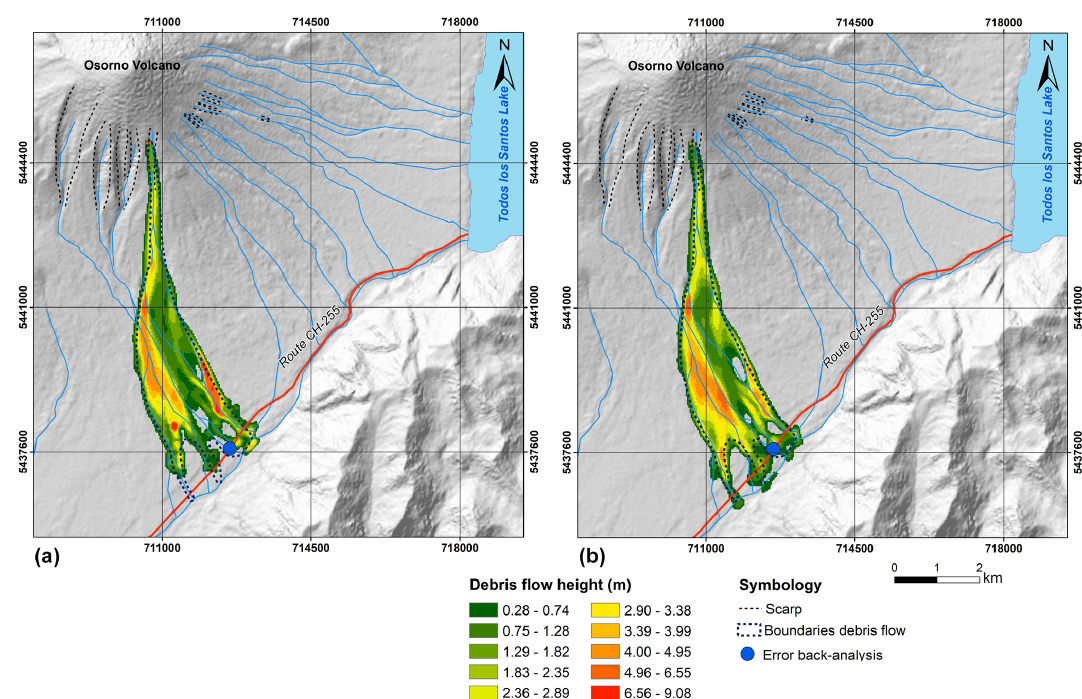
Figure 6. Simulation in the El Solitario sector, taking the release zone from the results obtained in the field. (a) Model with 60% water content in the ASTER DEM. (b) Model with 60% water content in the SRTM